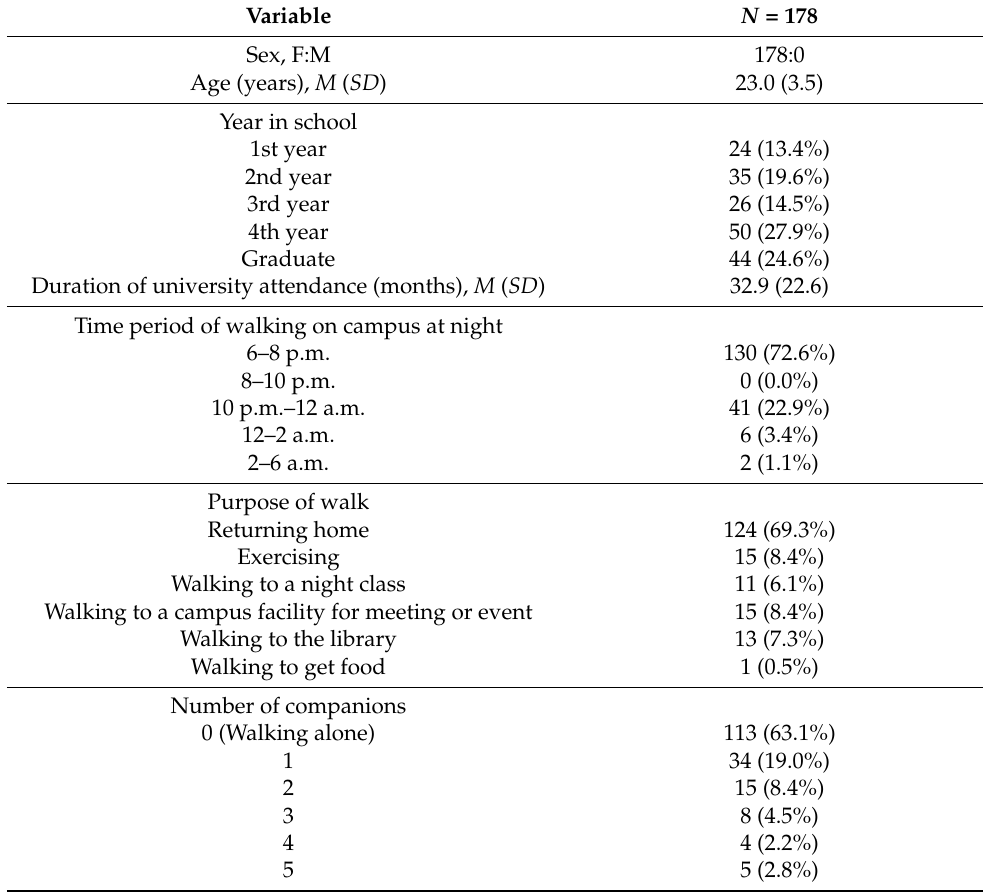
Table 2. Participants’ demographic information.